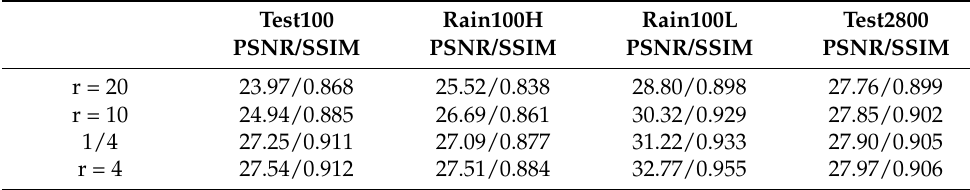
Table 5. Studies of reselecting data on a large-scale training set. r represents the proportion of reselected data to the total and 1/4 means fixed quarter of total